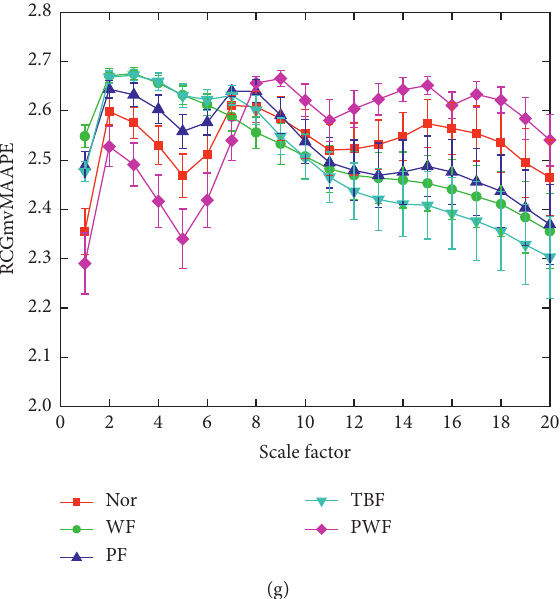
Figure 20: The entropy results of gearbox data analyzed by adopting seven approaches.